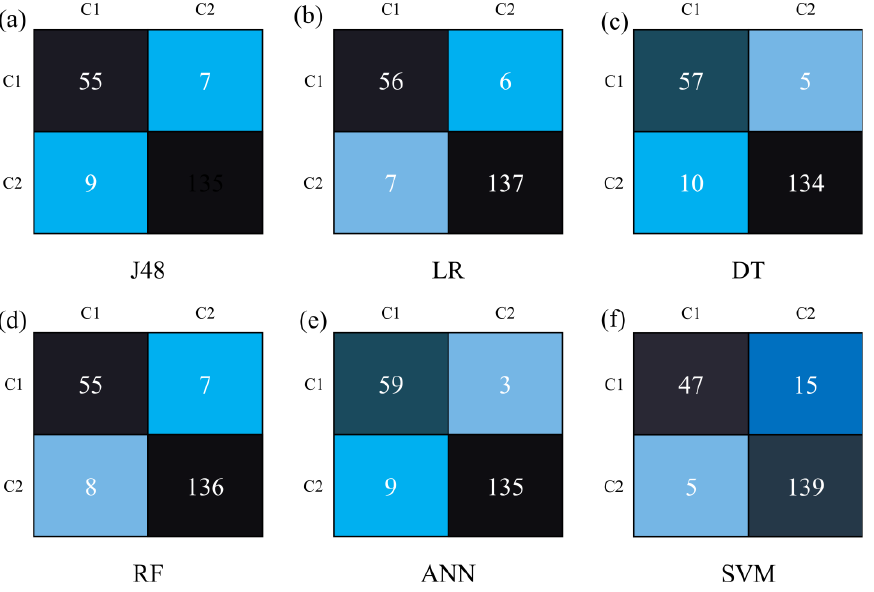
Figure 8. Confusion matrix to classify the clusters formed for the soybean genotypes for machine learning models tested (J48 decision tree algorithm–J48 ( a ), logistic regression–LR ( b ), REPTree decision tree algorithm–DT ( c ), random forest–RF ( d ), multilayer perceptron artificial neural network–ANN ( e ), and support vector machine–SVM ( f )) using the spectral bands as inputs. The main diagonal shows the number of correct classifications in each cluster.